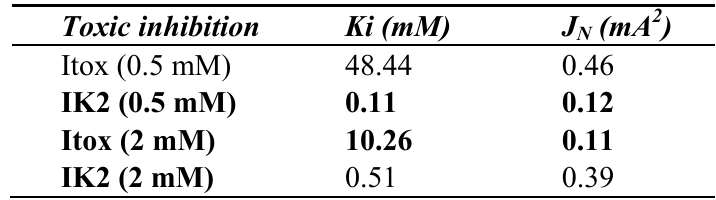
Table 2. Fitting of the polarization curve for 0.5 and 2 mM FeCN 63 − to the extended BVM models (Equations